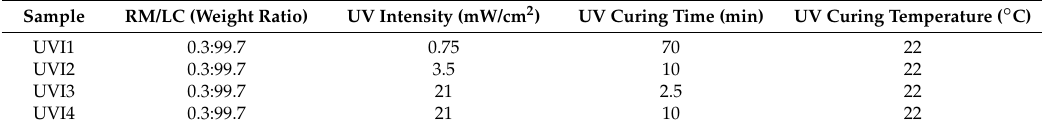
Table 5. A previous study presented one UV intensity (3.5 mW/cm 2 at 365 nm for 10 min) for RM polymerization [34]. To see whether UV intensity will affect the surface localized polymerization, we cured the cells at different UV intensities and different times, which is shown in Table 5. In each mixture, the added amount of PI was 1% with respect to the RM.